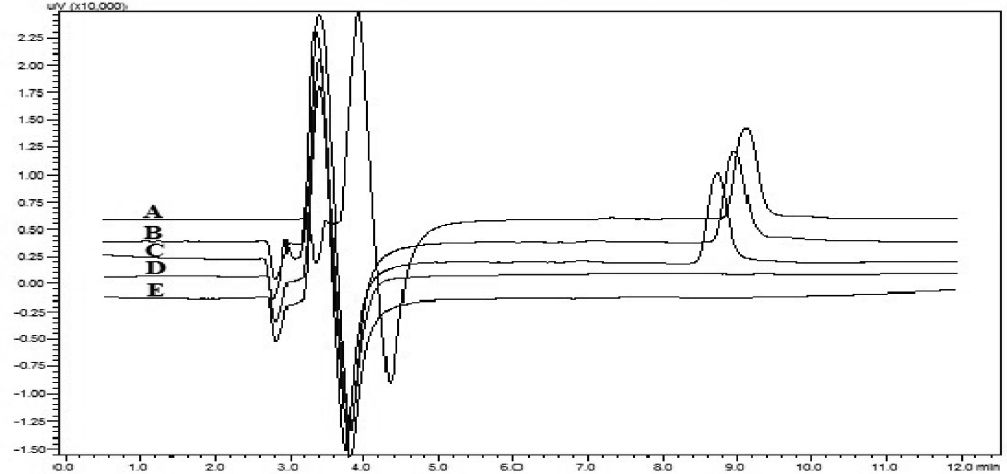
FIGURE 1 - Chromatograms corresponding to: (A) solution of MUP reference substance, (B) Nanocapsules of MUP and caprylic/ capric triglyceride oil, (C) Nanocapsules of MUP and rosemary oil, (D) Unloaded nanocapsules of rosemary oil and (E) unloaded nanocapsules of caprylic/capric triglyceride